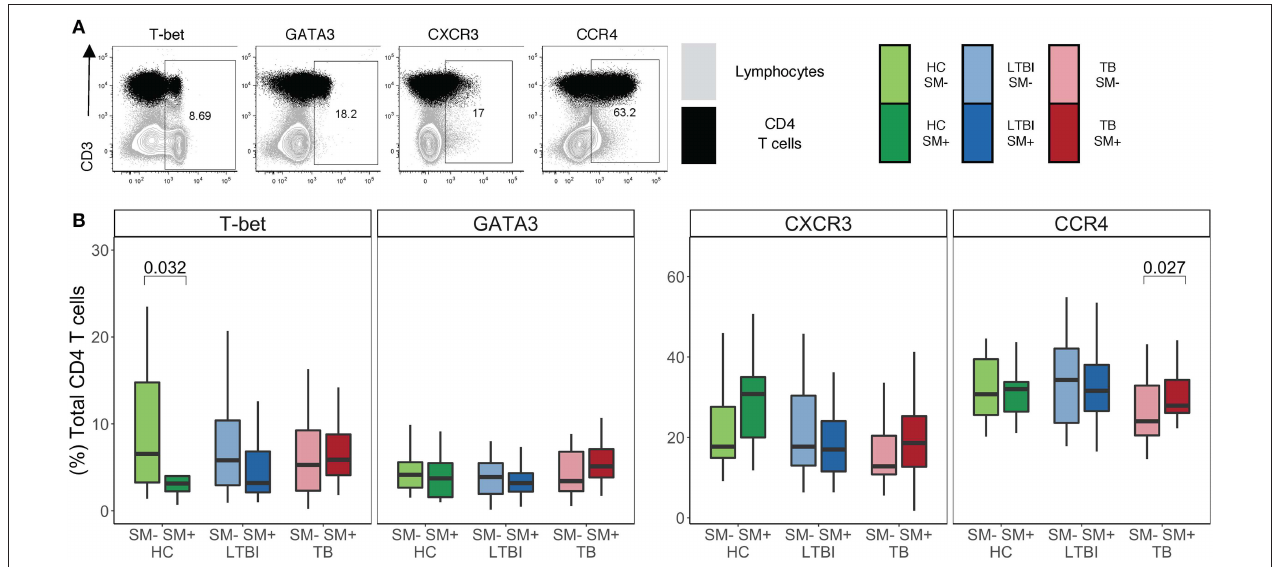
FIGURE 1 | Similar frequencies of CD4T cells express TH1 and TH2 lineage markers in SM + and SM − individuals, independent of Mtb infection status. Expression of transcription factors and chemokine receptors was measured by flow cytometry using PBMC samples obtained from individuals in each of six groups defined by Mtb and SM infection status: HC, LTBI, and TB, with or without concomitant SM infection (HC SM − , n = 24; HC SM + , n = 13; LTBI SM − , n = 25; LTBI SM + , n = 25; TB SM − , n = 25; TB SM + , n = 15). (A) Representative flow cytometry data from an SM + individual with active TB. Plots show cells gated on live CD3 + CD4 + CD8 − lymphocytes in black dots overlaying live lymphocytes in gray. (B) Frequency of indicated transcription factor + and chemokine receptor + amongst total CD4T cells. Boxes represent the median and interquartile ranges; whiskers represent the 1.5 * IQR. Differences in the frequency of each lineage marker + CD4T cell population between SM + and SM − individuals were assessed using a Mann Whitney U